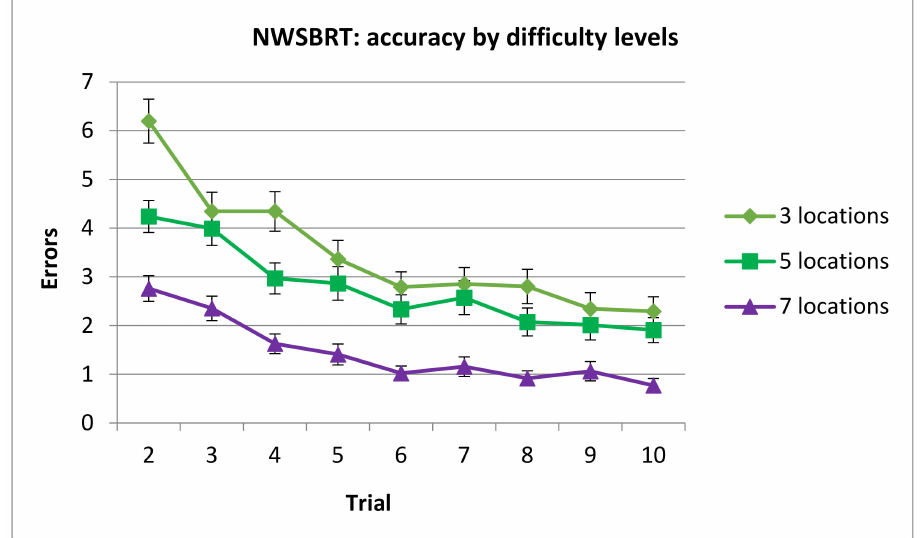
Figure 8. Mean number of errors by difficulty levels and trials in the NWSBRT. Note that trial 1 was removed from analysis since performance was at random. (Mean ±